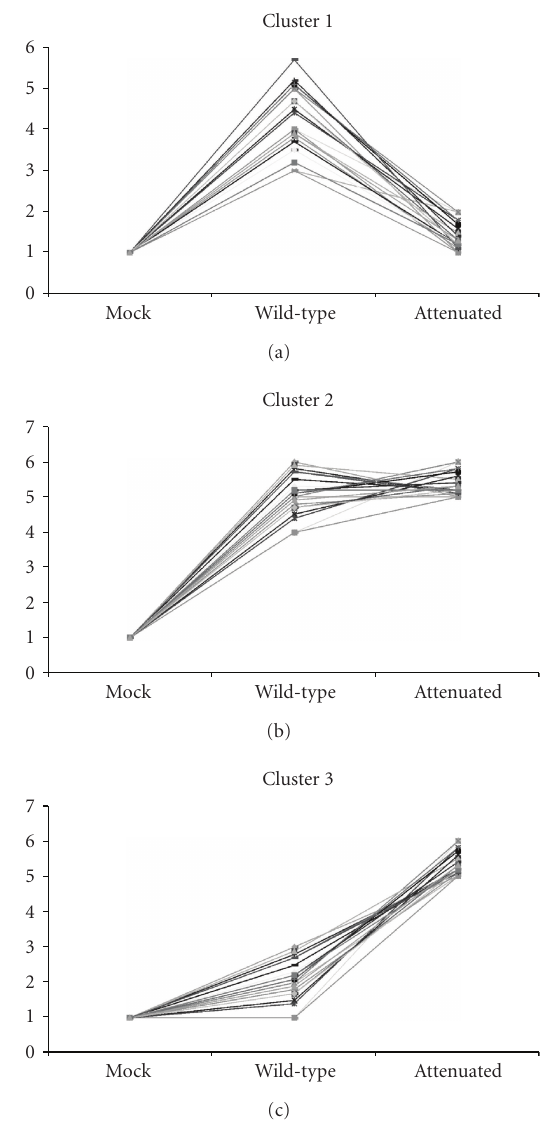
Figure 1: A generic example of analysis using k -means clustering. Data, such as from an mRNA expression microarray following mock, virulent, and attenuated infection of cell cultures or animals, are placed into clusters, on the basis of a similar pattern of expression to other genes in that cluster; lines represent an individual transcript. As can be seen, this type of analysis can quickly determine groups of transcripts which may associate with pathogenesis or